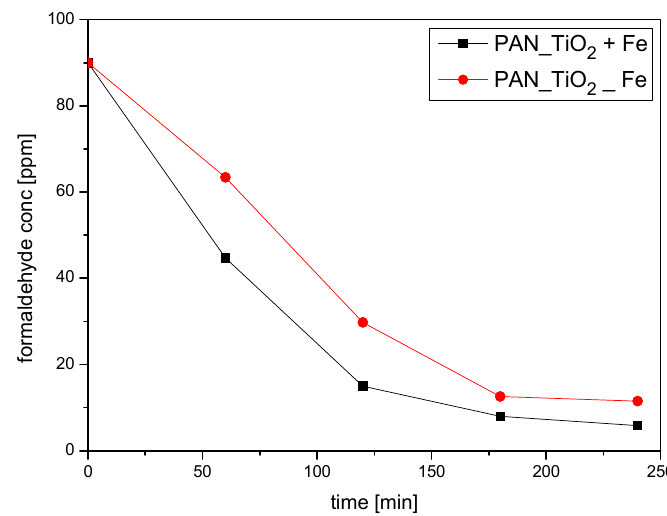
Figure 9. Formaldehyde concentration profile using heterogeneous photo-catalytic-Fenton with Fe supported (PAN_TiO 2 _Fe) or dispersed in solution (PAN_TiO 2 + Fe). The maximum standard deviation of the experimental points was 1.8 ppm.